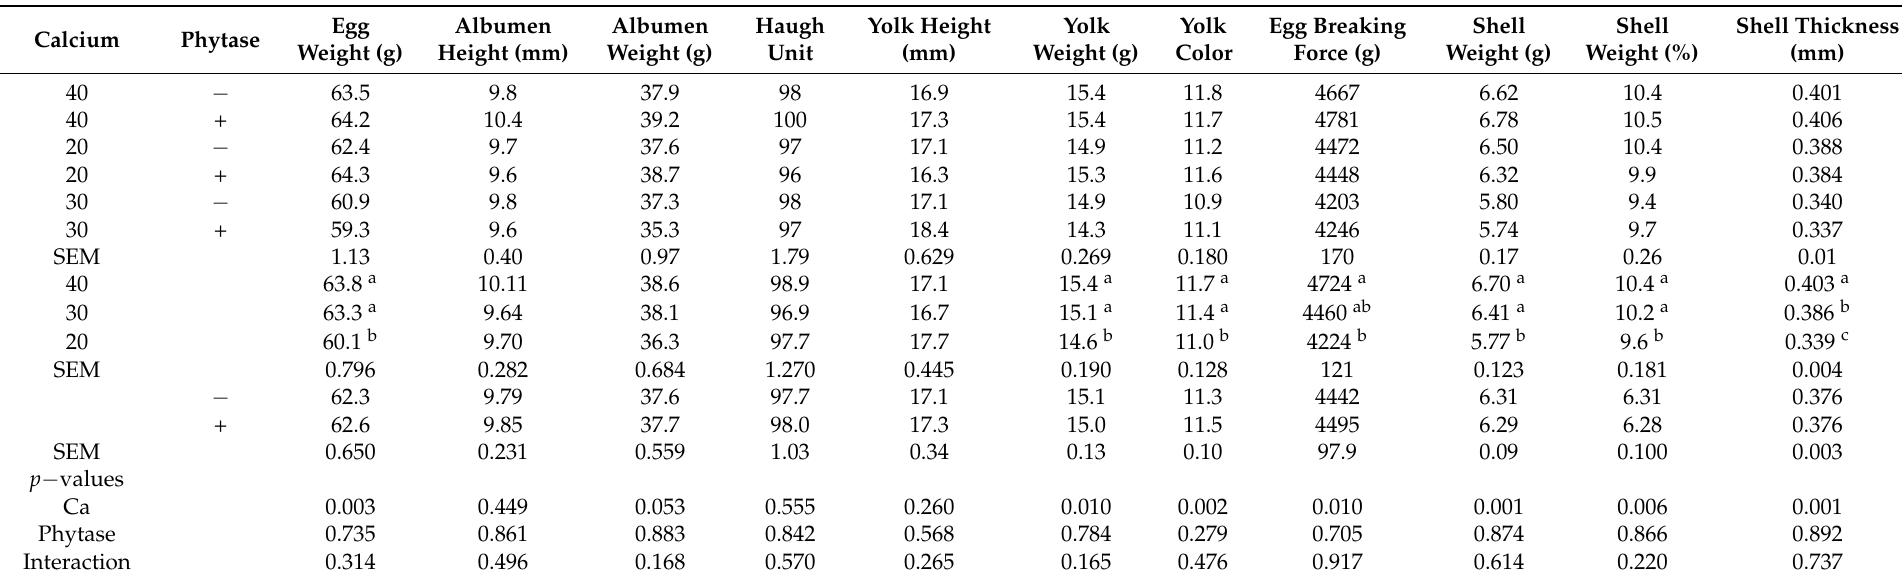
Table 5. Effect of differing Ca levels and addition of phytase on egg quality of laying hens (19–24 weeks of